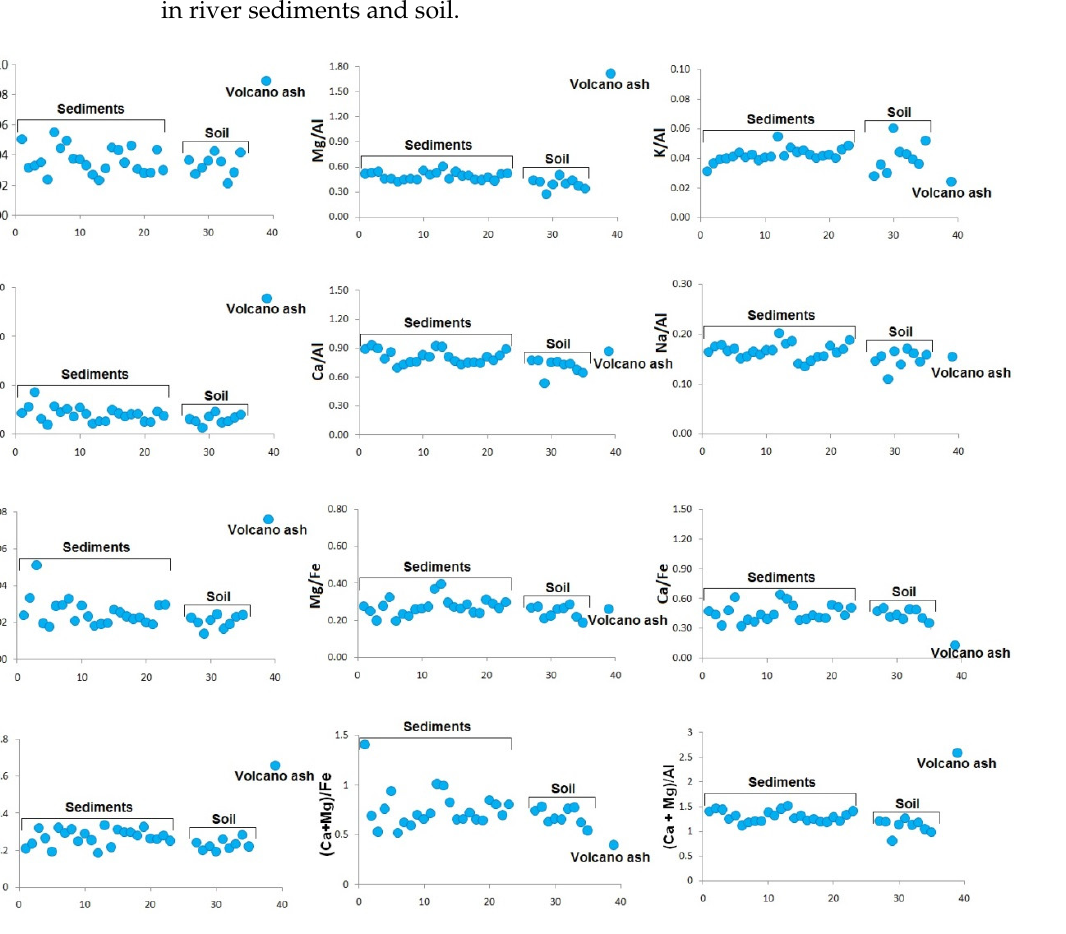
Figure 3. Characteristic ratios of sediment soil and volcanic ash samples. In crustal material from Iceland the (Ca + Mg)/Fe ratio ranged from 0.5 to 1.0 with one outlier of 1.5 in river sediment and in volcano ash was around 0.3 while 0.03 < K/Al < 0.06 and Na/Al < 0.2 respectively.